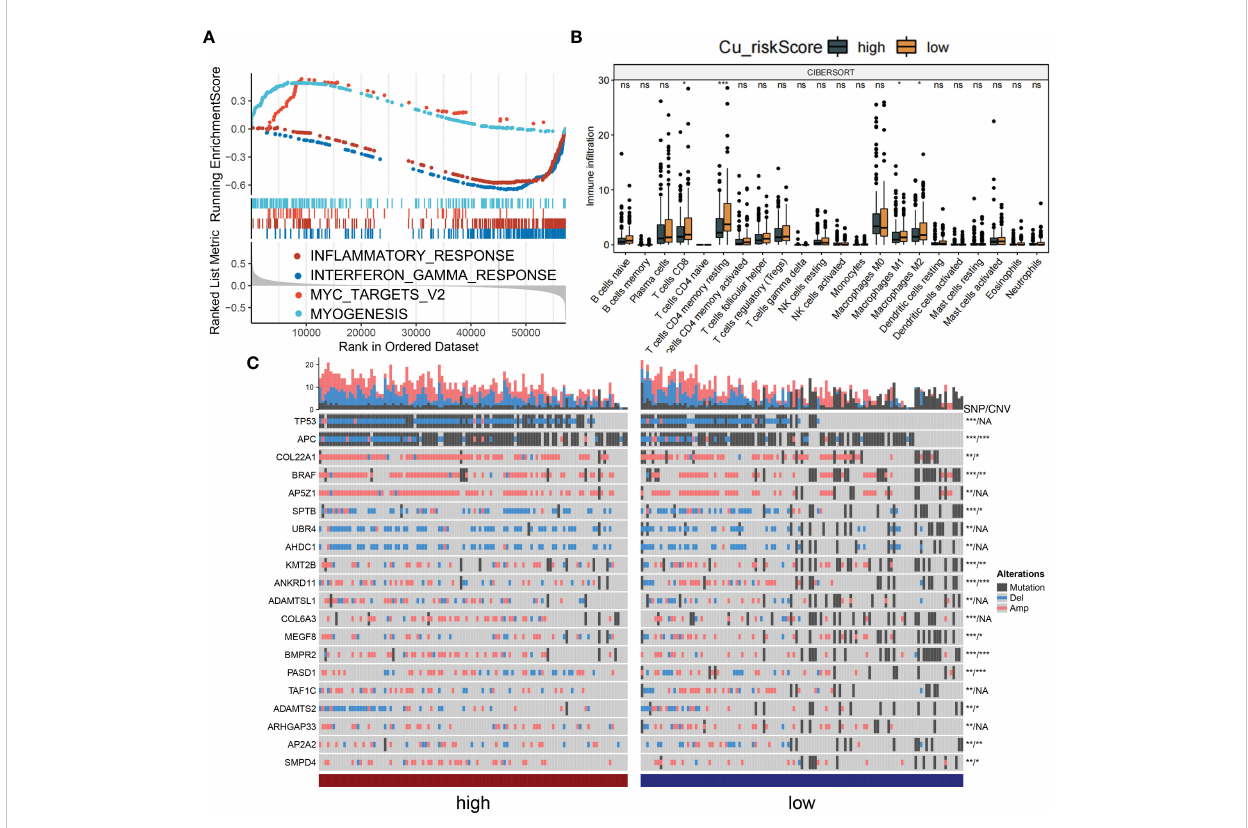
FIGURE 4 Biological value of Cu_riskScore. (A) GSEA running plot showing the top enriched biological process of Hallmark in TCGA. (B) Box plots showing immune in fi ltration levels in Cu_riskScore high and low based on CIBERSORTx algorithm. *P < 0.05, **P < 0.01, ***P < 0.001. ns, not statistically signi fi cant. (C) Heatmap showing the top 20 SNP with highest mutation rate in Cu_riskScore high and low groups and the corresponding CNV of each gene, *P < 0.05,**P < 0.01, ***P < 0.001. NA, not statistically signi fi